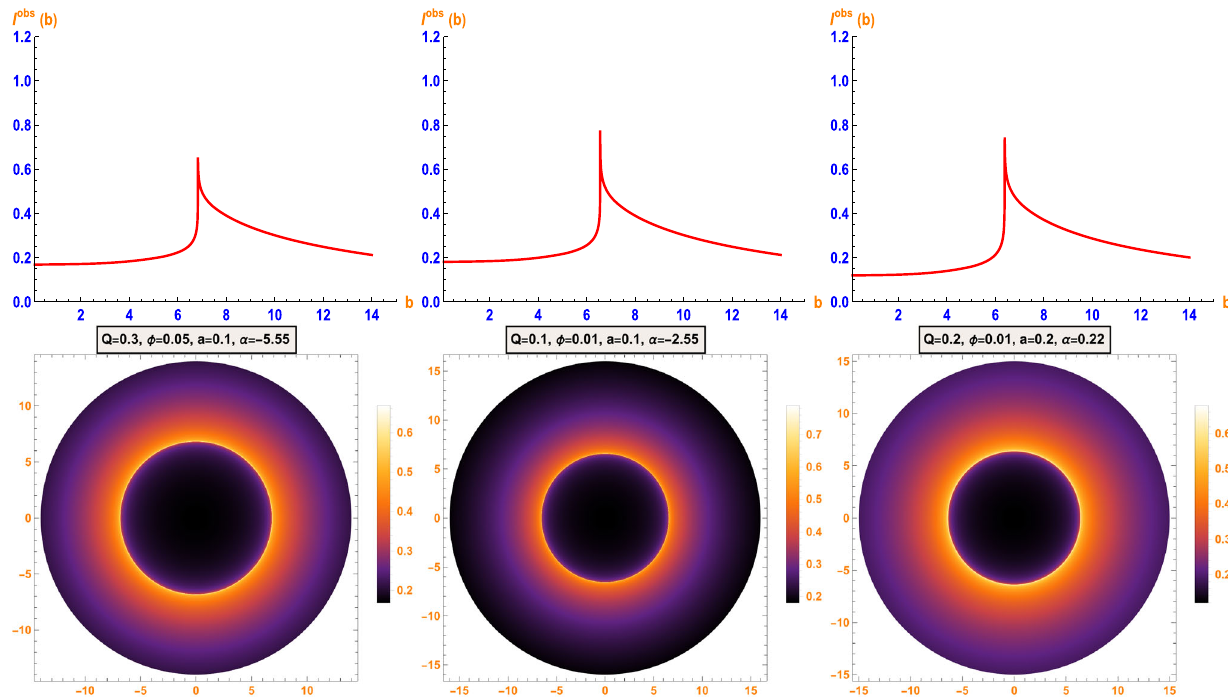
Fig. 8 The graphical interpretation of the total observed intensity I obs ( b ) , reflects by a static spherical accretion flow matter, for different BH state parameters and the mass of BH as M = 1. We choose these numerical values as three examples, and one can find a comprehensive details in